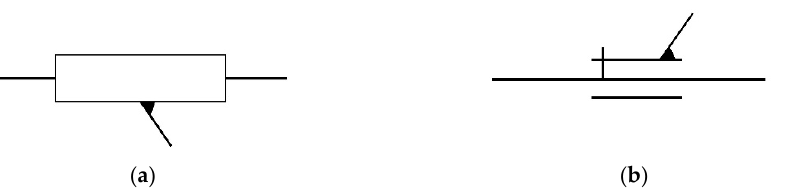
Figure 2. Representation of a servo axis according to the ISO3952 standard. ( a ) Basic symbol. ( b ) Admissible symbol. ( b ) Admissible